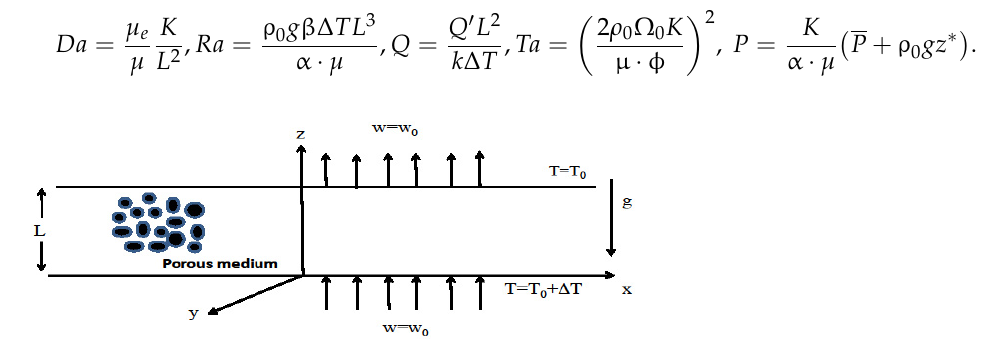
Figure 1. Schematic of the problem.